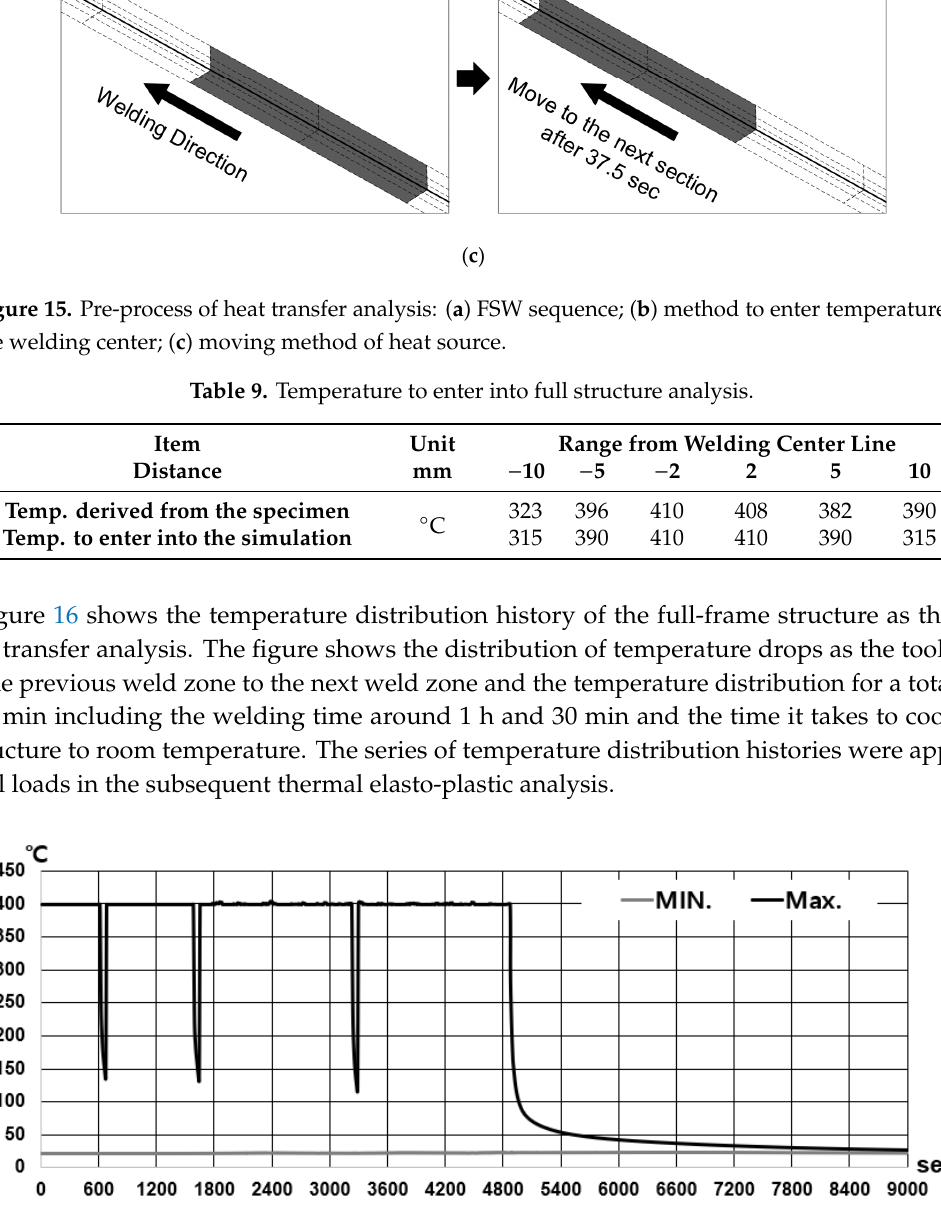
Figure 16. Temperature distribution history of the full-frame structure.